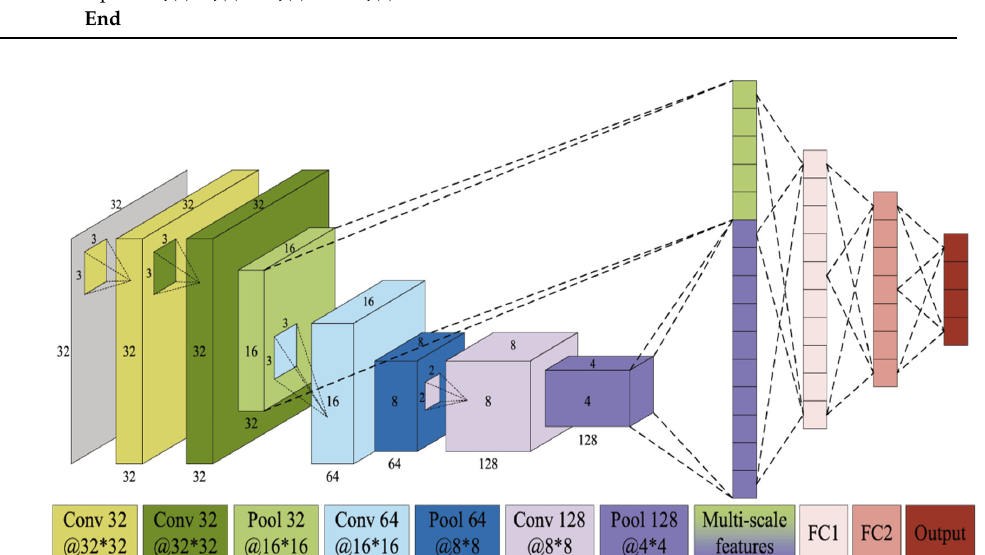
Figure 5. Structure of MS-CNN.